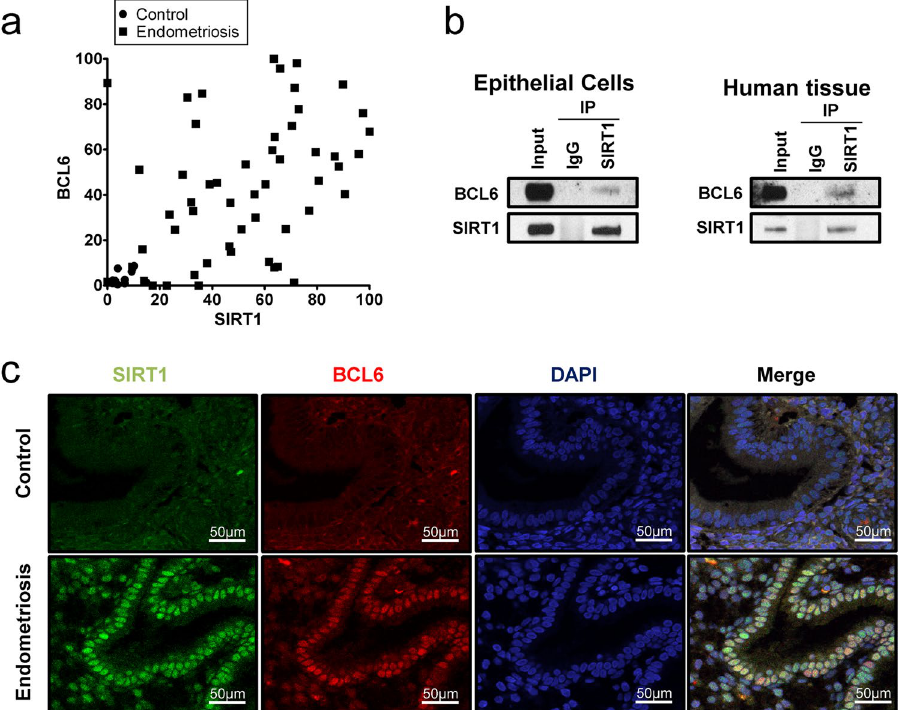
Figure 3. Correlation of between SIRT1 and BCL6. ( a ) Correlation analysis between SIRT1 and BCL6 in human endometrium with endometriosis. ( b ) Immunoprecipitation (IP) analysis between SIRT1 and BCL6 in Ishikawa cells and Human endometrium with endometriosis. Representative blots have been cropped to reduce unnecessary area. Full-length blots are presented in Supplementary Fig. S4. ( c ) Co-localization of SIRT1 and BCL6 in the human endometrium without and with endometriosis by immunofluorescence